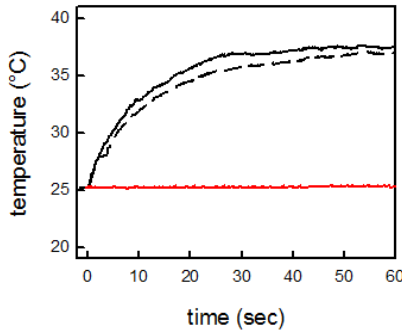
Figure 3. Temperature increase as a function of irradiation time, measured under NIR laser irradiation (808 nm, 0.26 W/cm 2 ) for a freshly prepared GLASS-PEI-TRI sample (black solid line) and for a GLASS-PEI-TRI sample after an immersion of 48 h in water (black dashed line). The red solid line represents the thermogram obtained for an uncoated glass in the same conditions.